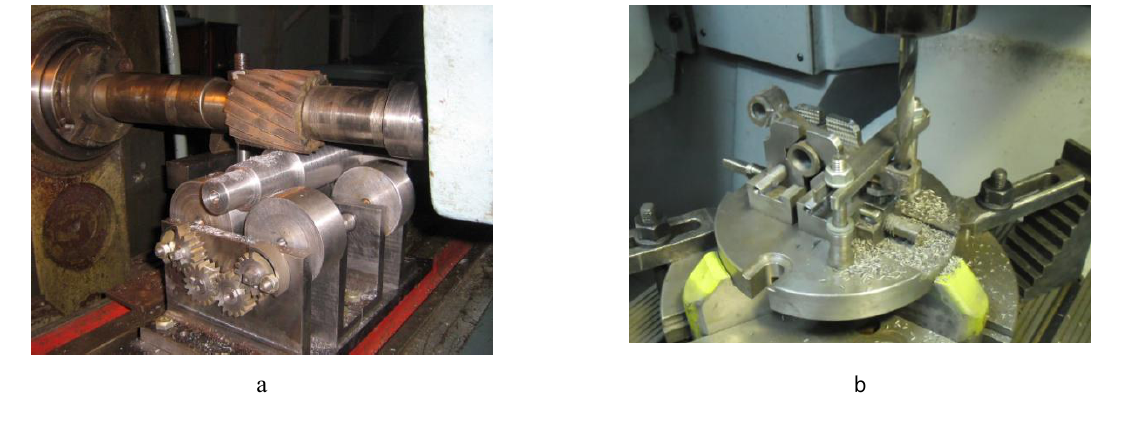
Figure 6. Experimental researches of modular adjustable fixtures for shafts (a) and levers